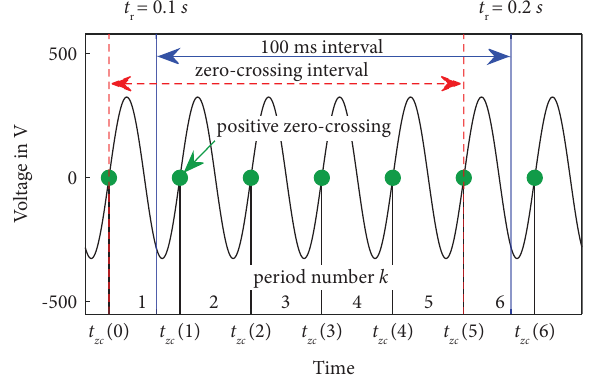
Figure 8: Zero-crossing algorithm (ZC algorithm). Illustration of the zero-crossing positions relative to a 100 ms time